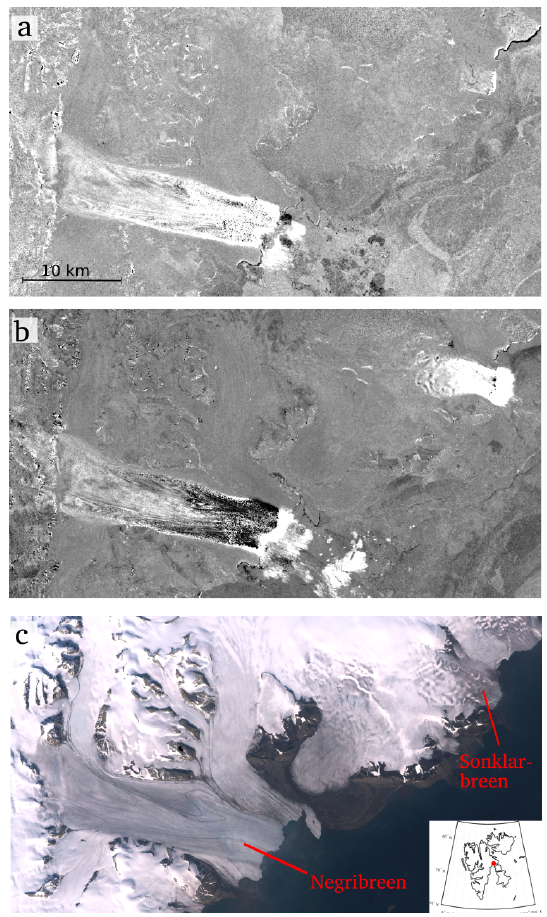
Figure 2. Copernicus Sentinel-1 NDI image of Negribreen and Son- klarbreen, Svalbard, for the periods (a) 2018–2019, and (b) 2019– 2020. (c) Copernicus Sentinel-2 1 July–31 August 2019 optical composite image, with a cloud mask in black. The inset shows the location in Svalbard of the glaciers shown in the